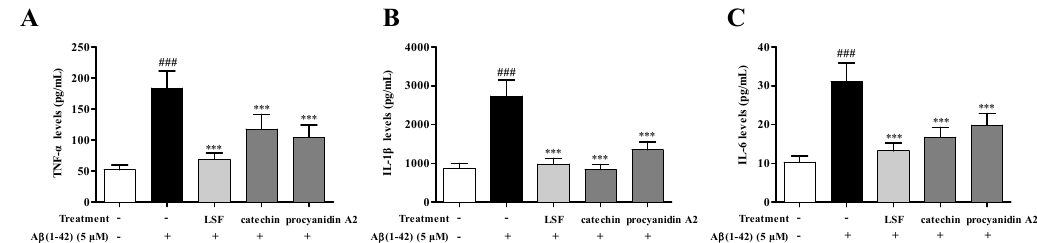
Figure 3. The release of TNF-α, IL-1β, and IL-6 in Aβ(1-42)-induced BV-2 cells under the treatments of LSF, catechin, and procyanidin A2. BV-2 cells were pretreated with 5 μM Aβ(1-42) for 12 h, followed by incubations of LSF (0.469 μg/mL), catechin (10 μM), and procyanidin A2 (10 μM) for another 12 h. After treatment, the cell free supernatants were subsequently employed for TNF-α ( A ), IL-1β ( B ), and IL-6 ( C ) assays using ELISA kit. BV-2 cells treated with medium alone were set as the control group, and BV-2 cells treated with 5 μM Aβ(1-42) alone were set as the Aβ group. ### p < 0.001 vs. control group; *** p < 0.001 vs. Aβ group. Data are the mean value ± S.D. of ten independent experiments.